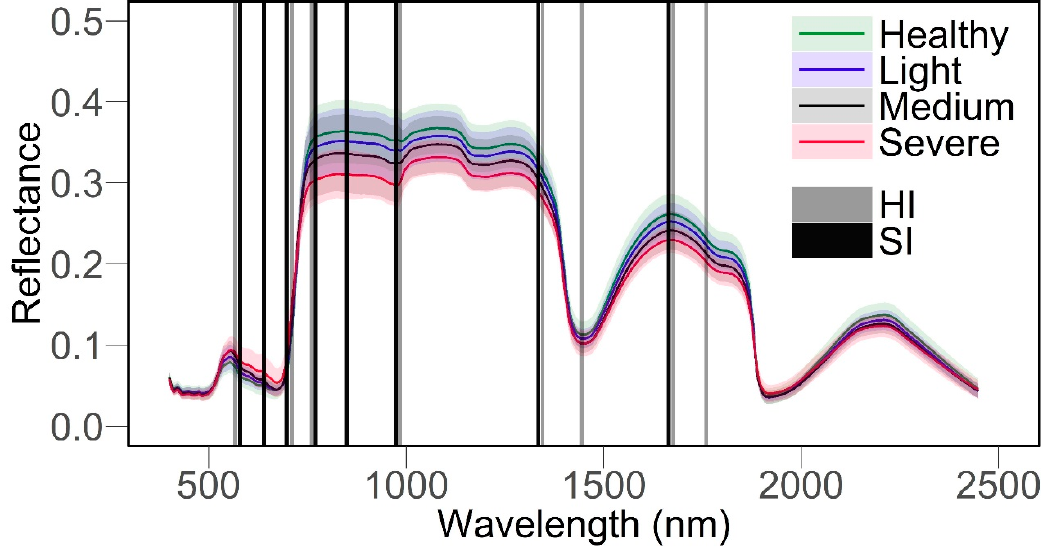
Figure 4. Mean (line) and standard deviation (shade area) of spectral reflectance of healthy and SCR-infected corn leaf groups with different severity levels. The grey and dark lines show the wavelengths selected for Health Index (HI) and Severity Index (SI) development, respectively.